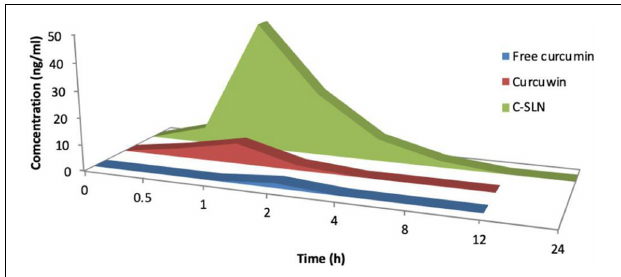
FIGURE 7 | Mean concentration-time area curve of curcumin rat after single oral does of free curcumin, curcumin R (cid:13) and CLEN.